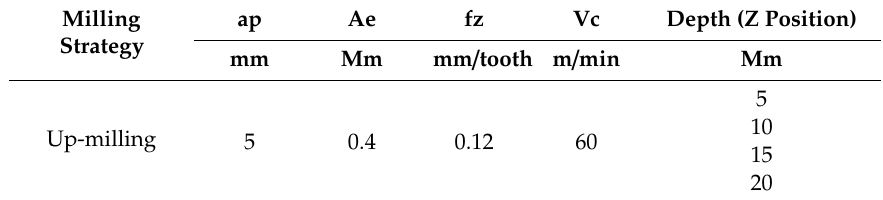
Table 3. Cutting conditions in the analysis of the influence of the depth (Z position of the tool).